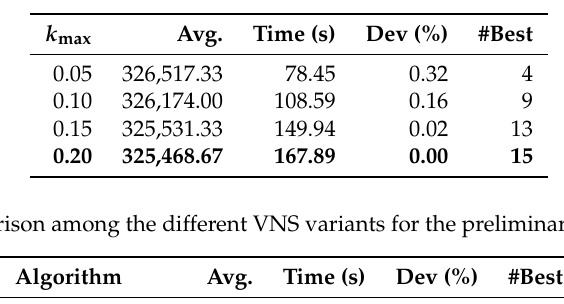
Table 4. Comparison of the different k max values considered in the General Variable Neighborhood Search (GVNS) algorithm.